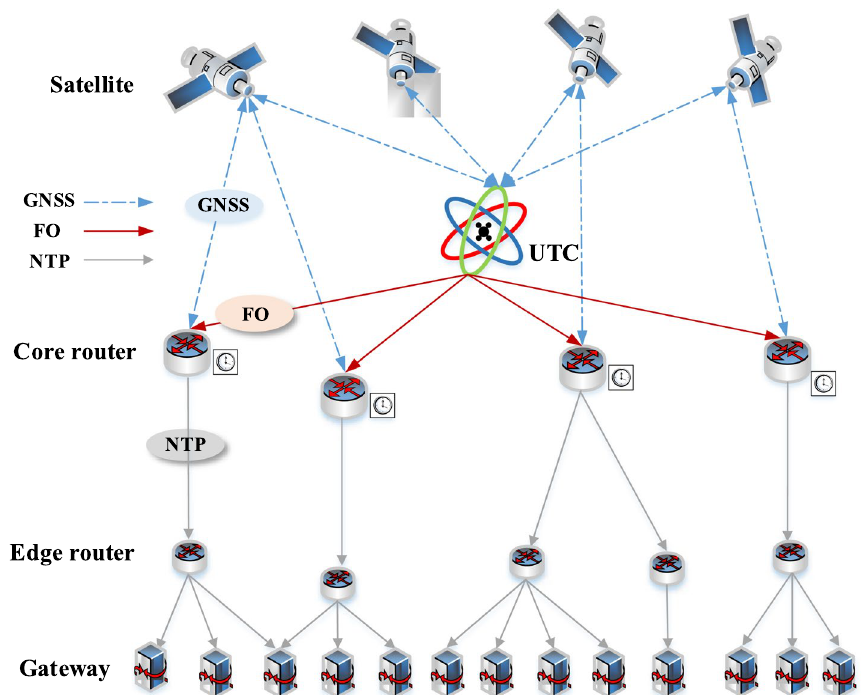
Fig. 1 The clock synchronization of a telecom network. GNSS, global navigation satellite systems; FO, fiber-optic; NTP, network time protocol; UTC, coordinated universal